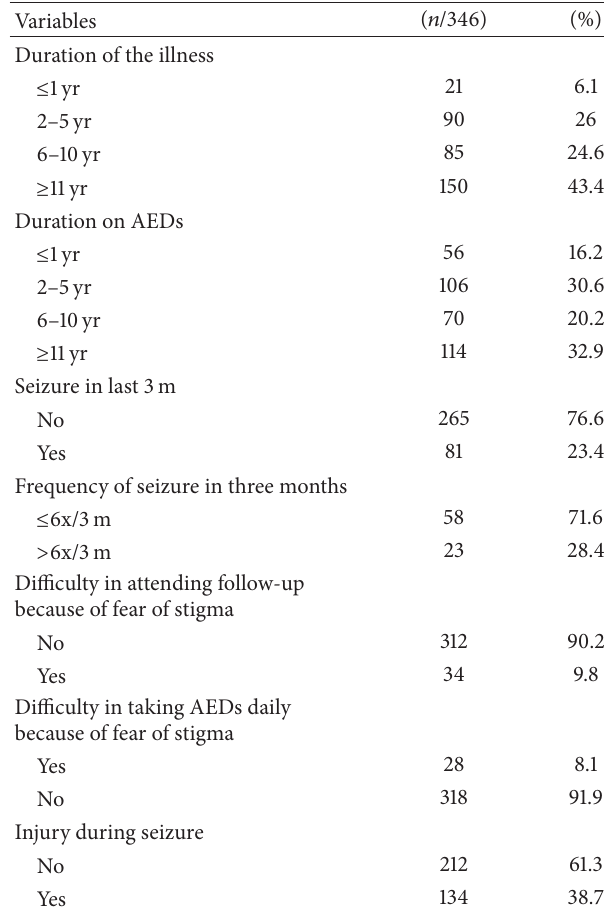
Table1:Distributionofstudysubjectsbysociodemographicfactors. Table 2: Distribution of study subjects by clinical